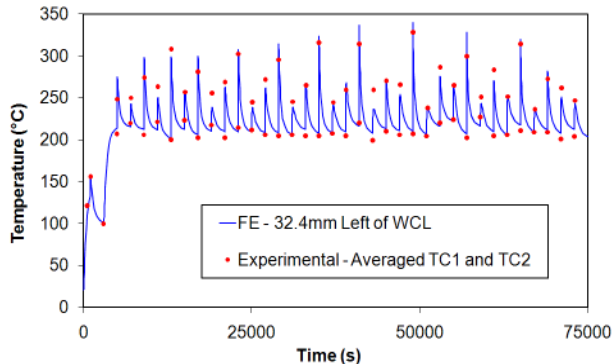
Figure 12. Temperature measurements by TC3 and FE temperature history.